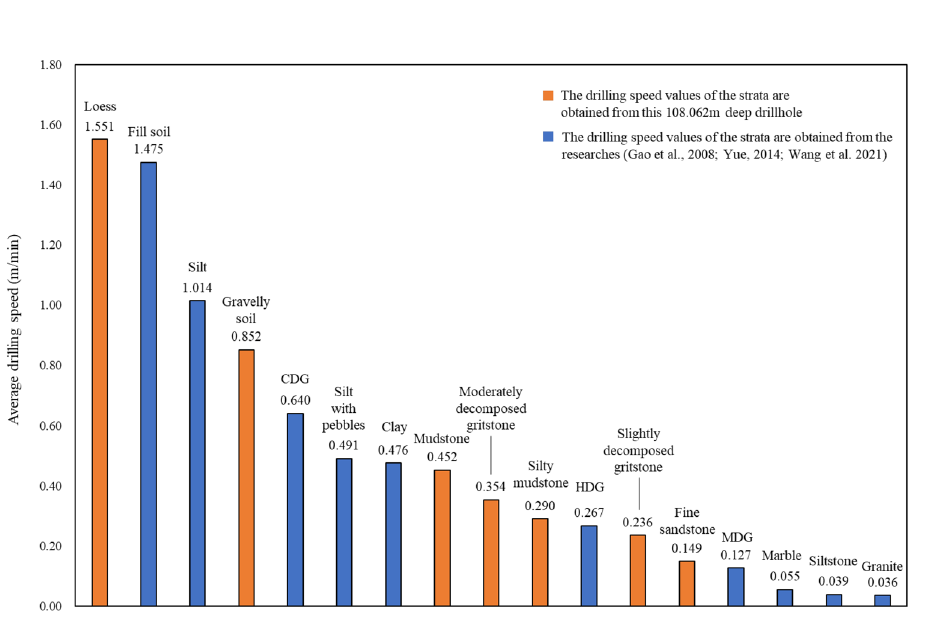
Figure 8. The average drilling speed for different geomaterials in the